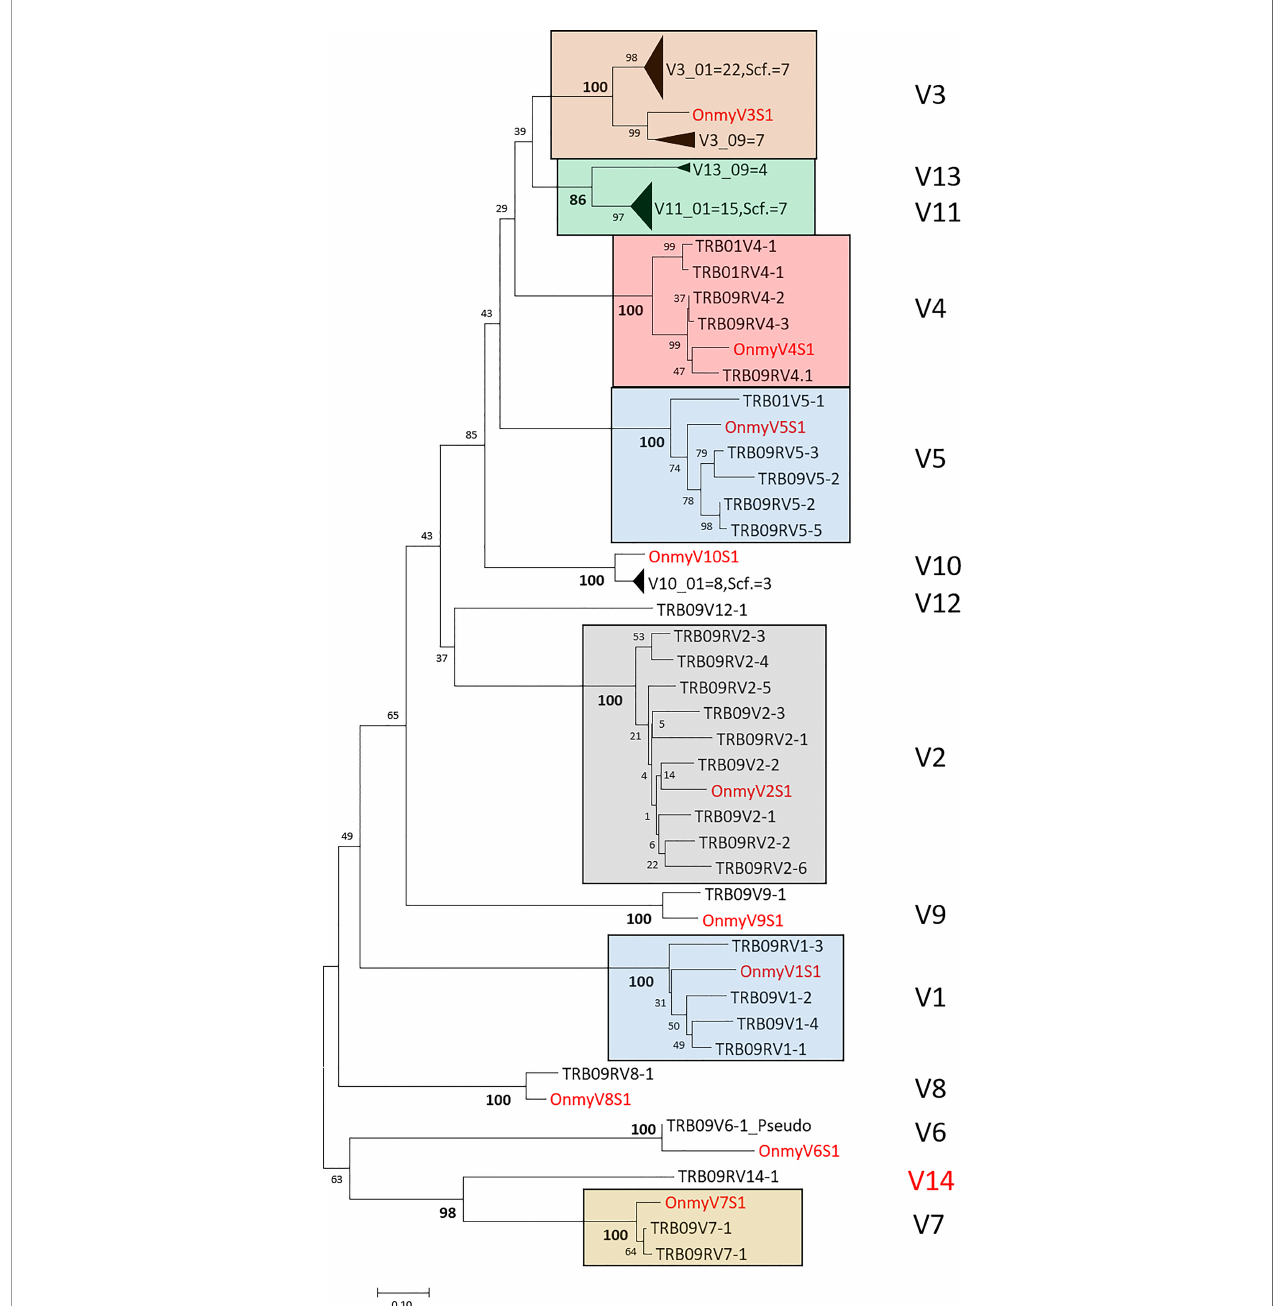
FIGURE 3 | Phylogeny of deduced amino acid sequences for TRB variable (V) subgroup members from rainbow trout and Atlantic salmon. Large clusters are collapsed showing only number of V sequences originating from chr.01 (01), chr.09 (09) or the unplaced scaffold (scf.) where for instance V3_01 = 22, Scf. = 7 indicates that there are 22 V3 sequences from chr.01 and 7 V3 sequences from the unplaced scaffold in this collapsed cluster. Only one representative rainbow trout (Onmy) sequence is used per variable subgroup (17). The Atlantic salmon TRB09V6 is the only pseudogene sequence included in the tree. The optimal tree with the sum of branch length = 9.56583678 is shown. The evolutionary distances were computed using the Poisson correction method (50) and are in the units of the number of amino acid substitutions per site. The analysis involved 113 amino acid sequences with a total of 113 positions in the fi nal dataset. Rainbow trout sequences are shown using red font and large V clusters are shown using colored boxes with subgroup category on the right hand side. GenBank accession numbers for rainbow trout variable sequences are: V1S1 (U18123), V2S1 (U18124), V3S1 (U18125) (16), V4S1 (AY135385), V5S1 (AY135386), V6S1 (AY135387), V7S1 (AY135389), V8S1 (AY135390), V9S1 (AY135391), V10S1 (AY135392)